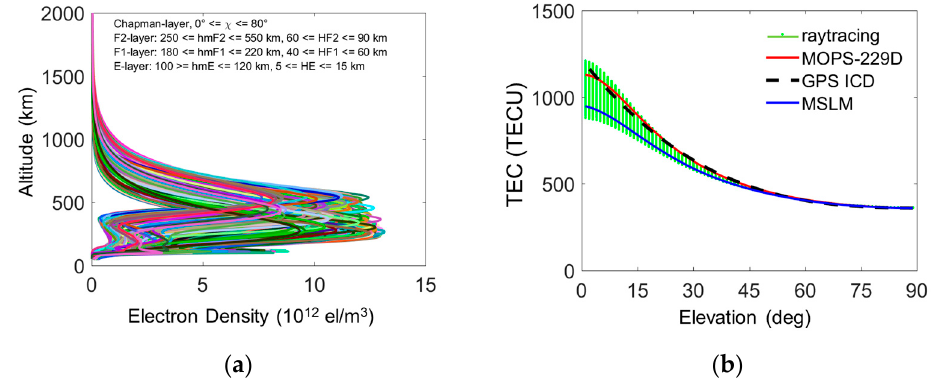
Figure 8. Left image ( a ) shows about 2000 simulated profiles for the same vertical TEC (VTEC) of 360 TECU. The right panel ( b ) shows the variation of slant TECs computed by di ff erent mapping functions (MFs) as well as by ray tracing (green plot) as a function of elevation